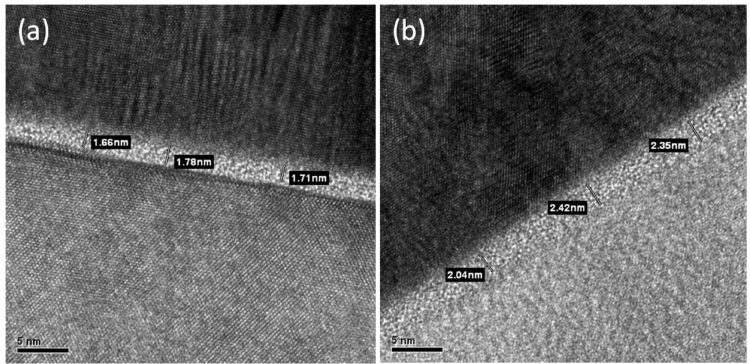
Figure 5. Transmission electron microscopy (TEM) figures of ( a ) 200 ◦ C and ( b ) 300 ◦ C AZO thin